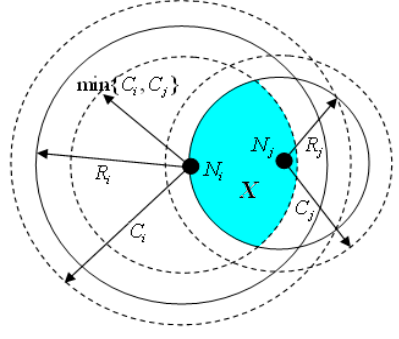
Figure 4. The point within the sensing range of N i being covered by its neighbor.